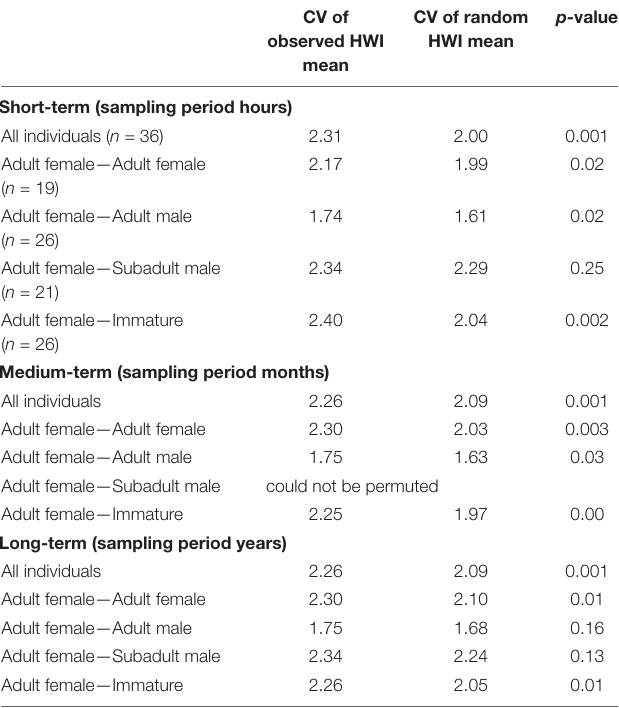
TABLE 4 | Permutation tests for preferred associations within and between age classes and sexes for individuals captured on ≥ 3 occasions for short-, medium-, and long-term between 2011 and 2019.